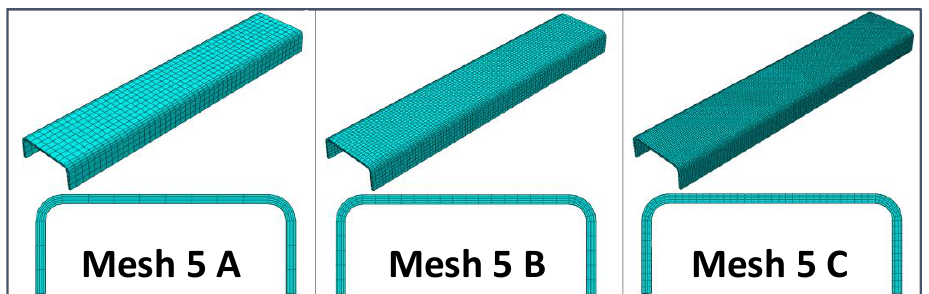
Figure 4. Three elements in the thickness direction: Coarser mesh (Mesh 3A), intermediate mesh (Mesh 3B), and finer mesh (Mesh 3C).